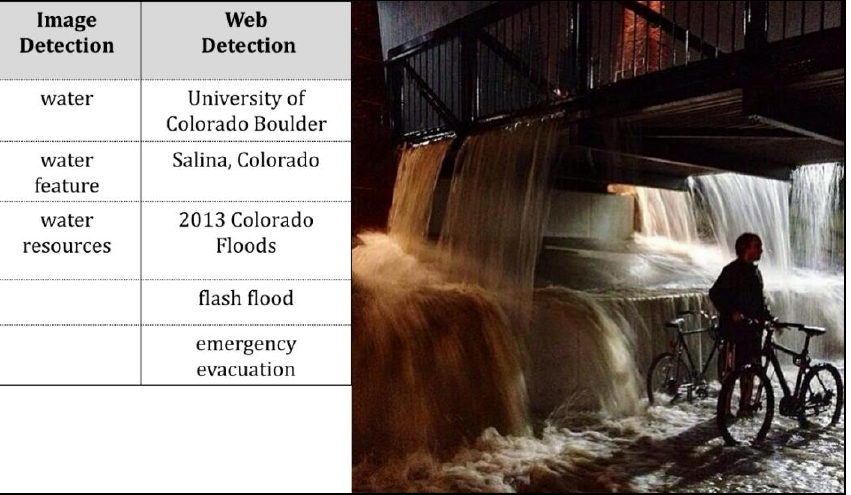
Figure 7. Web detection performed better.